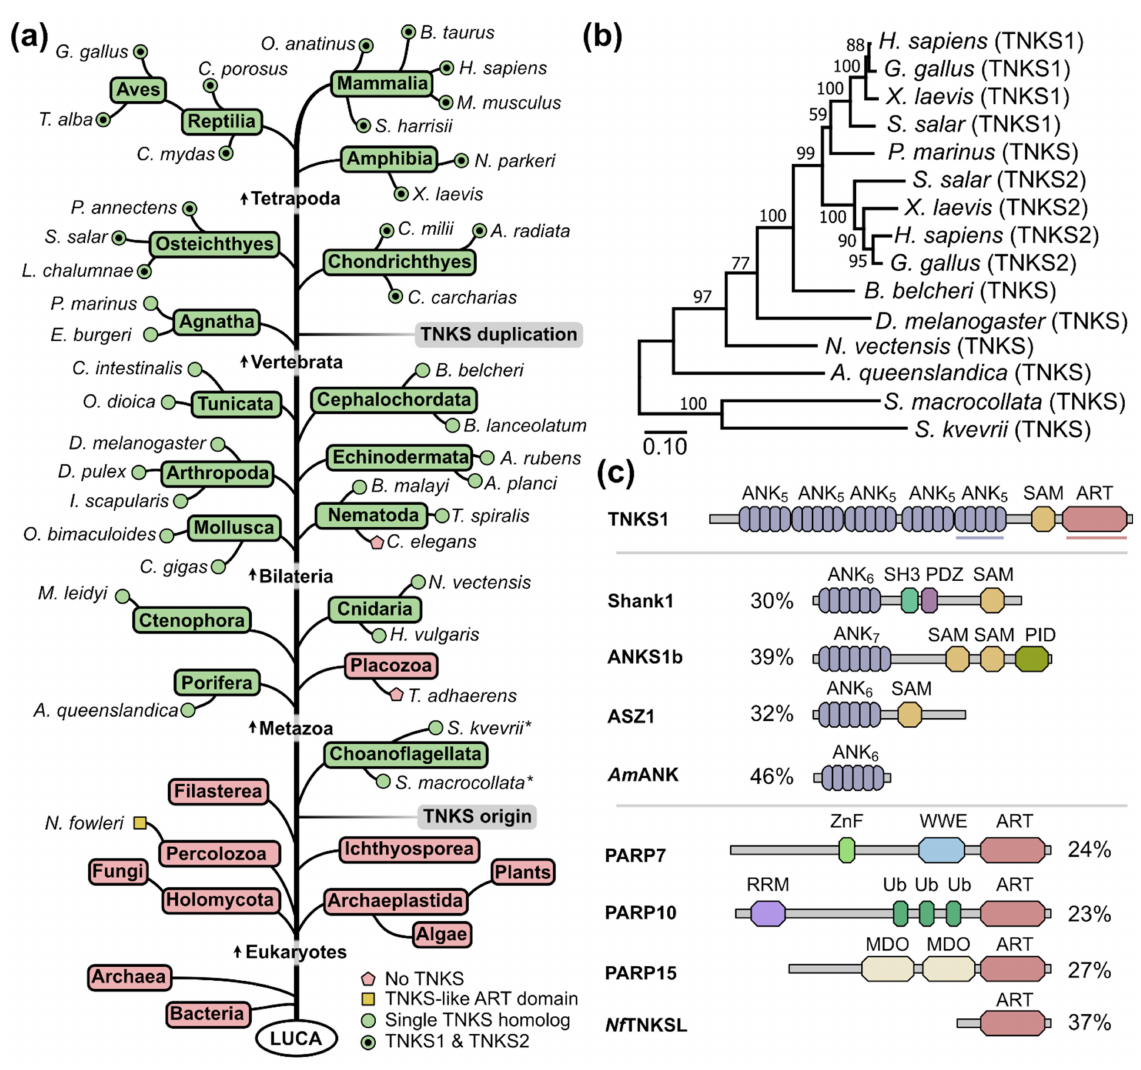
Figure 2. Distribution and possible origin of tankyrases. ( a ) The presence or absence of TNKSs in phylogenetic groups was determined from searches of various protein and genomic databases. Phylogenetic relationships among groups are schematically depicted. Representative species are shown for metazoans and selected groups and the presence of a single TNKS or both TNKS1/2 paralogs is indicated. Information with common names for the phylogenetic groups and species displayed here together with identifiers for the protein sequences can be found in Table S1. Species in which TNKSs were identified only from TSA data are marked (*). LUCA = Last universal common an- cestor. ( b ) Phylogenetic reconstruction from TNKS sequences using the maximum likelihood method. Percentages for bootstrap support values are shown for each node. Bootstrap tests were conducted with 1000 bootstrap replicates. The analysis was performed with truncated TNKS sequences starting from the ARC3 domain to match the likely incomplete sequence from S. macrocollata . In Figure S1, the reconstruction was alternatively performed with the neighbor joining method. ( c ) Schematic representation of proteins with domain architectures related to TNKSs. Sequence identity percentages to the ARC5 or ART domain of human TNKS1 were derived from local sequence alignments. Shank1, ANKS1b and ASZ1 are human proteins that contain both ANK and SAM domains. The ANK protein from Acidianus manzaensis ( Am ANK) shares a high sequence identity with ARC5 of TNKS1. The number of ankyrin repeat units is indicated for each ANK domain. PARP7, PARP10 and PARP15 are human representatives from the clade 3 of the ARTD family, which is most closely related to clade 4 (TNKSs) [52]. The TNKS-like protein from the amoeba N. fowleri ( Nf TNKSL) is described in more detail in Figure